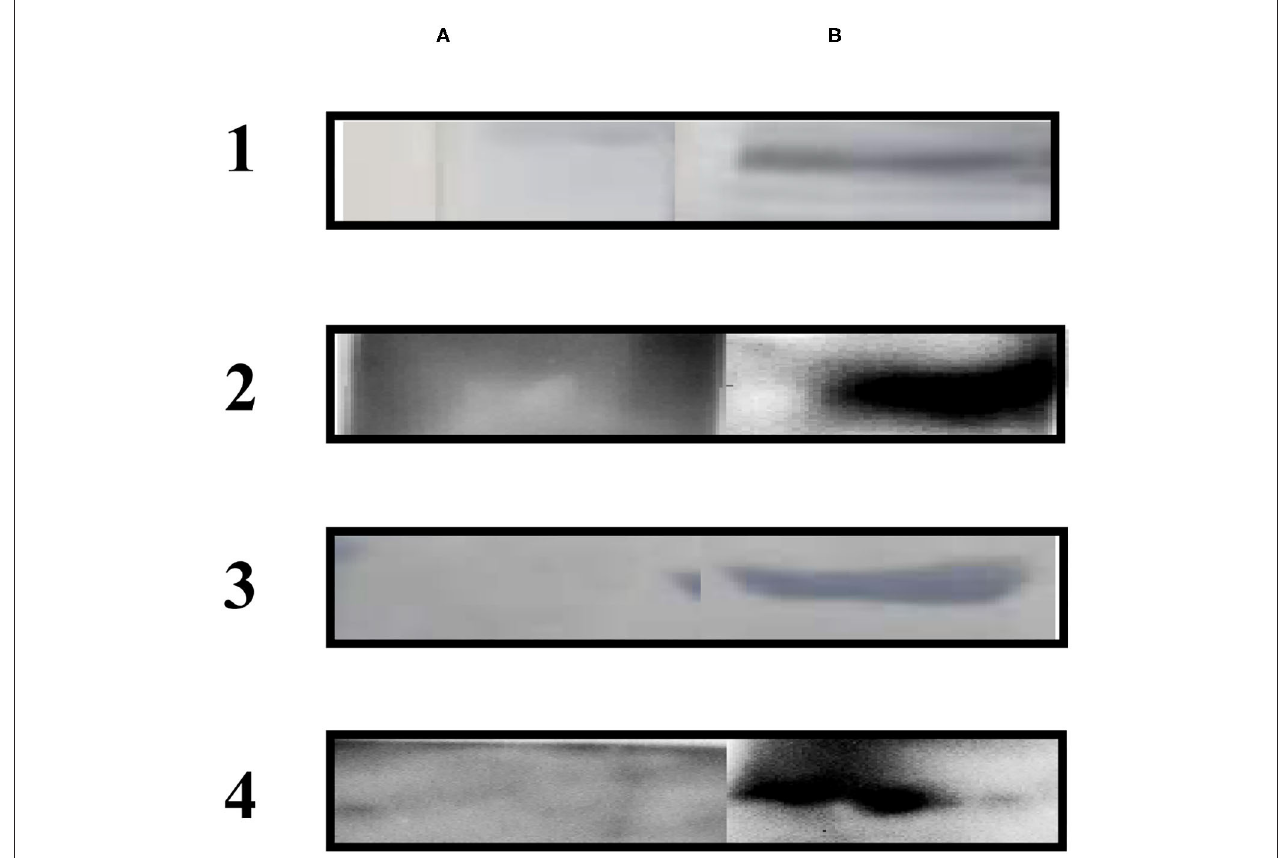
FIGURE 5 | Western blotting analysis. (A) Lane A1: total protein extracts of PSCs probed with pre-immunized dog sera; Lane A2: total protein extracts of PSCs probed with pre-immunized dog sera; Lane A3: non-infected dog sera was used to probe purified rEg-TSP11; Lane A4: non-infected dog sera was used to probe purified rEg-actin. (B) Lane B1: total protein extracts of PSCs probed using anti-rEg-TSP11 dog sera; Lane B2: total protein extracts of PSCs probed using anti-rEg-actin dog sera; Lane B3: purified rEg-TSP11 probed with the serum of E. granulosus infected dog; Lane B4: purified rEg-actin probed with the serum of E. granulosus infected